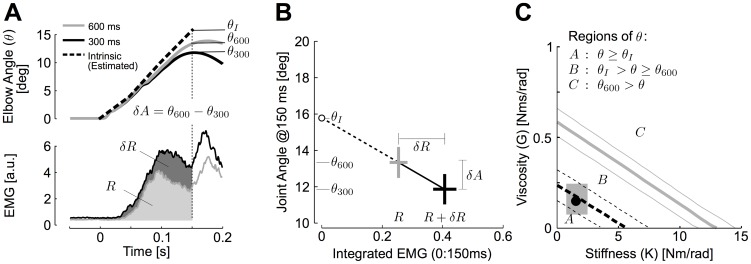
Validation of model parameters.A: Relationship between the integrated EMG (δR) and the corresponding change in joint angle at 150 ms (δA) across the timing conditions. The ratio δA/δR was used to extrapolate the joint displacement at 150 ms resulting from the intrinsic joint impedance only (θI). Dashed line denotes estimated contribution generated by muscle intrinsic mechanical properties. B: Extrapolation of changes in joint angle as a function of changes in integrated muscle response used to estimate θI. The same extrapolation based on integrated EMG and joint angle at distinct times provided similar results. Crosses illustrate 1 SEM across participants. C: Regions of the parameter space (K and G) predicting changes in simulated joint angle at 150 ms ≥θI (region A), between θI and θ
600 (region B) and <θ
600. The boundary between the regions A and B is the set of values of K and G that best corresponds to our data. Upper and lower boundaries were obtained by varying the segment inertia by ±5%. The black dot represent the estimates derived from the muscle model (Equations 6). The gray rectangle shows the worst-case variation in K and G resulting from ±25% errors in the muscles model parameters (see Results).